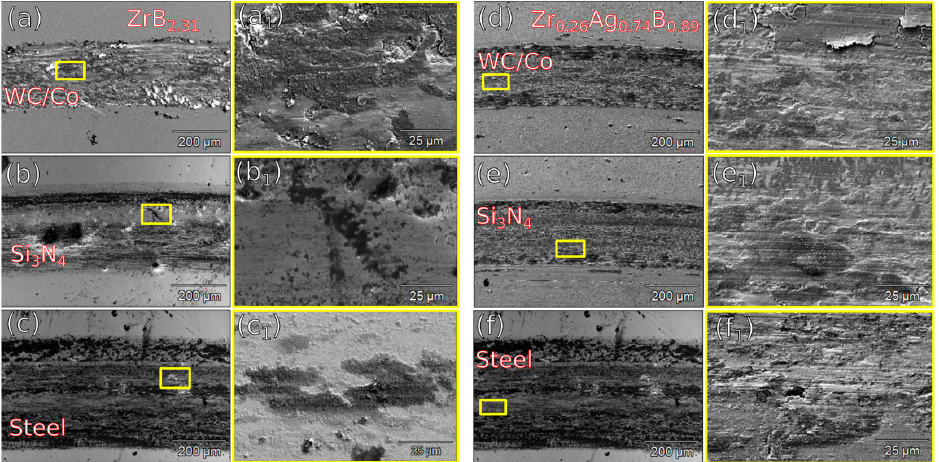
Figure 7. Wear tracks of ZrB 2.31 sample from the view of SEM worn against di ff erent counterpart materials: ( a ) WC/Co, ( b ) Si 3 N 4 , ( c ) Steel. Details of these wear tracks (( a 1 ) WC/Co, ( b 1 ) Si 3 N 4 , and ( c 1 ) steel) and wear tracks of Zr 0.26 Ag 0.74 B 0.89 from the view of SEM against di ff erent counterpart material (( d ) WC/Co, ( e ) Si 3 N 4 , and ( f ) steel)), with corresponding wear track details (( d 1 ) WC/Co, ( e 1 ) Si 3 N 4 ,